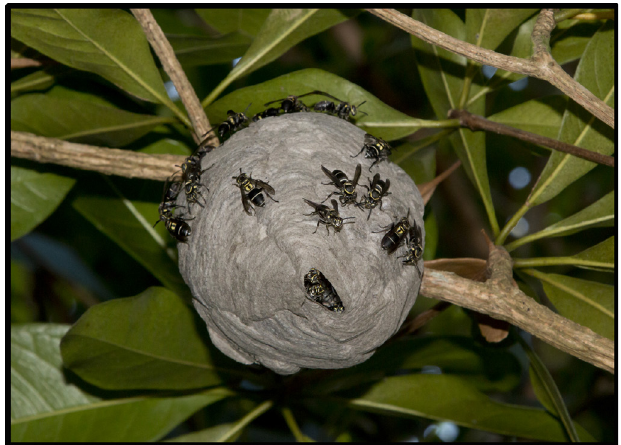
Fig 6 . Early nest of Chartergellus trinitatis.